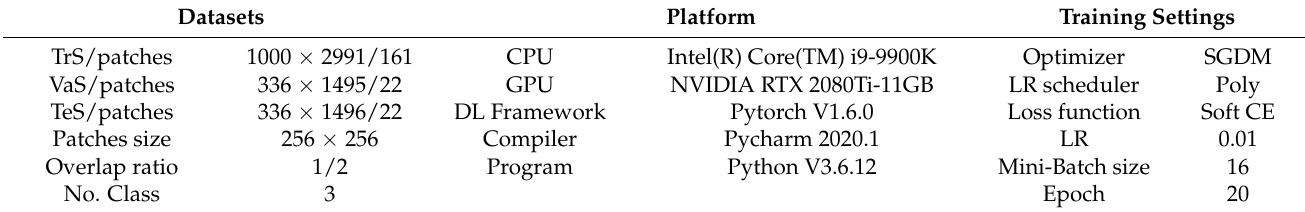
Figure 11. Dataset division for training, validation and test. Table 2. Details of experiment